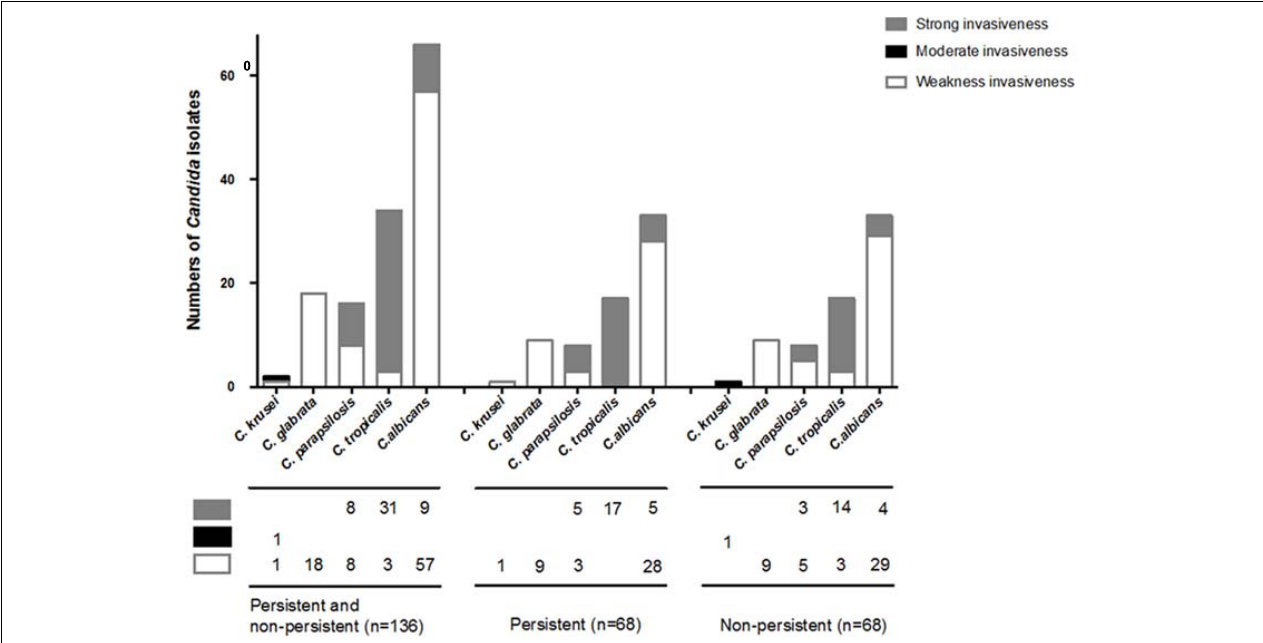
FIGURE 4 | Invasiveness on Candida species isolated from persistent and non-persistent candidemia. Invasiveness was tested on 136 Candida strains isolated from including patients after propensity-score matching. Candida strains were streaked out with a flat toothpick to form single colonies (typically 50 colonies/plate) on YPD plates (yeast extract “Difco” 2%, Bacto Peptone “Difco” 4%, glucose 2%, Bacto-agar “Difco” 2%, and tryptophan 0.003%). All plates were incubated at 37 ◦ C and the extent of invasion was scored after 2 days. Invasion was determined as (i) cells that had not invaded the agar were washed away by rubbing the plate with a gloves finger while rinsing under running water, (ii) cells that had invaded the agar remained as macroscopically visible micro-colonies on the surface of the washed plate, and confirmed by micro-scopical examination (with a bright light field, 10 × magnification) after washing. Candida strains with strong/intermediate invasiveness were not significantly different among the isolates from the patients between persistent and non-persistent group. In the 136 Candida strains, C. tropicalis (31/34; 91.2%) was the highest proportion of strains with strong invasiveness, followed by C. parapsilosis (8/16; 50%) and C. albicans (9/66; 13.6%).